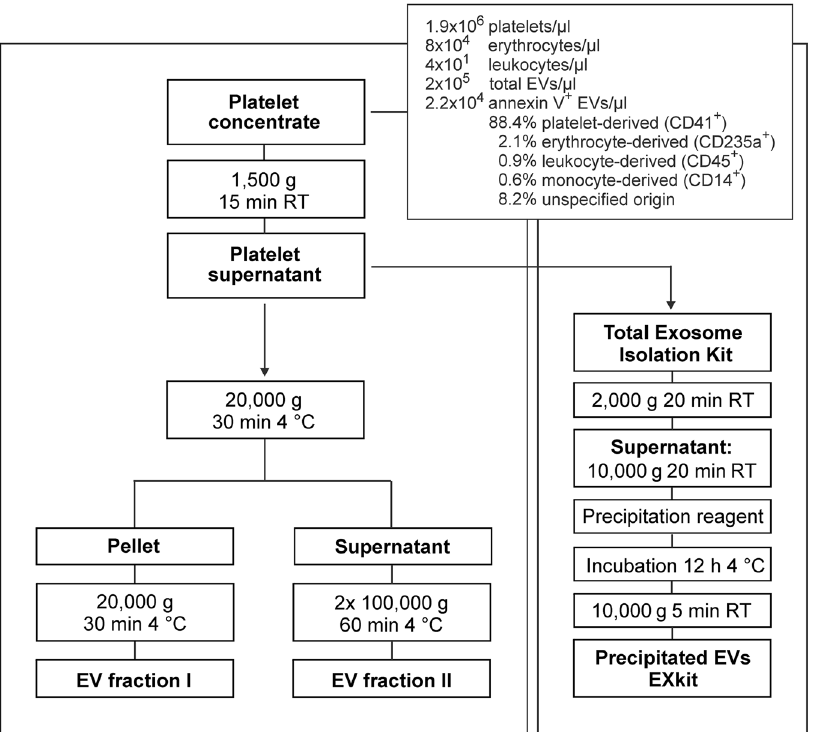
Figure 1. Isolation of extracellular vesicles (EVs). EV fractions were isolated from fresh medical grade platelet concentrates from healthy donors. After removal of platelets by centrifugation at 1,500 g, EVs were obtained by sequential centrifugation of the supernatant at 20,000 g and 100,000 g, respectively, yielding EV fraction I and EV fraction II. For comparison, polymer precipitation using a commercial exosome isolation kit was applied, yielding the EXkit fraction. RT, room